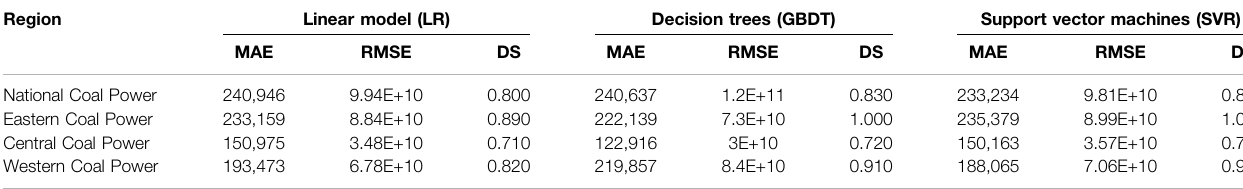
TABLE 2 | Comparison of evaluation indexes of linear and non-linear results. Region Linear model (LR)